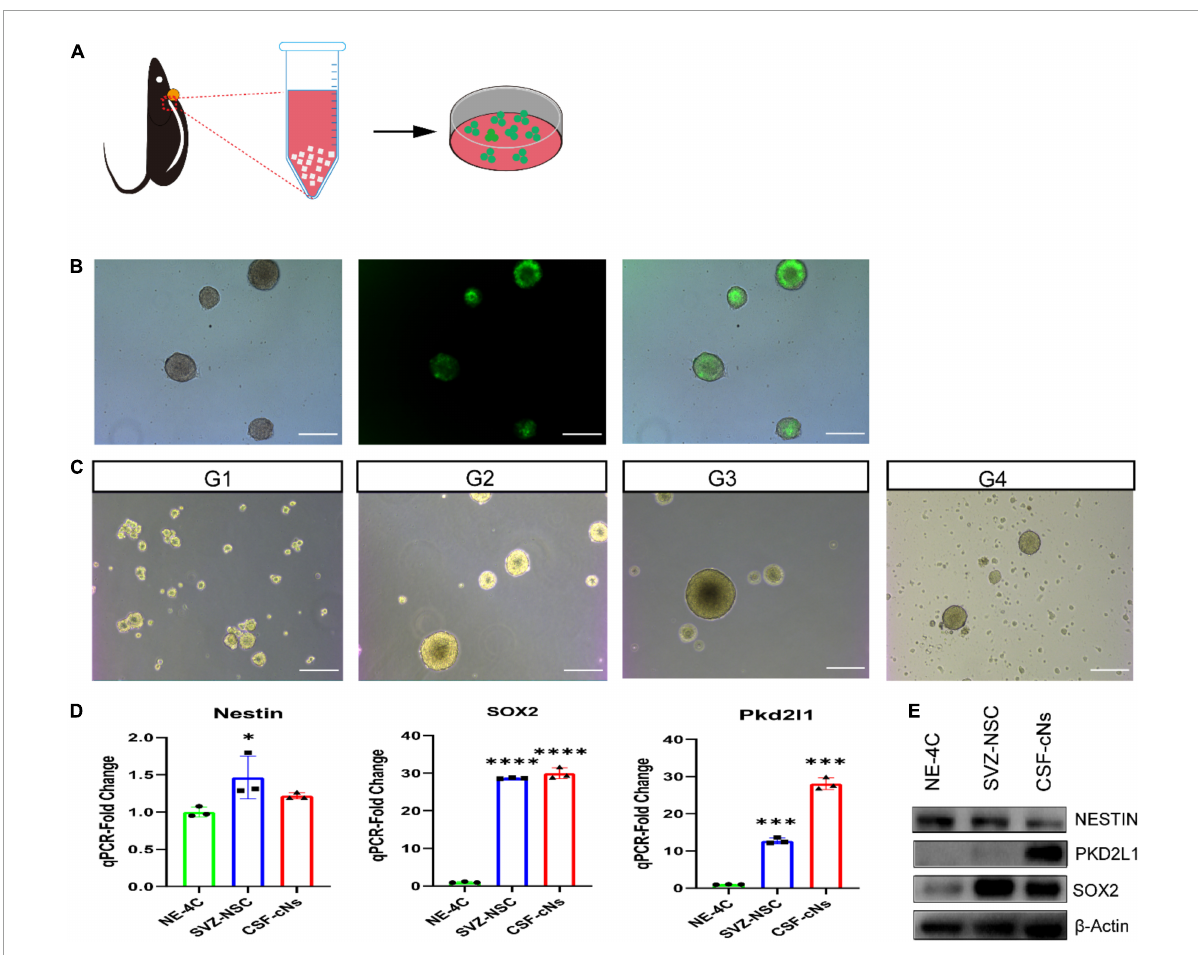
FIGURE2 Cerebrospinal fluid-contacting neurons (CSF-cNs) formed neurospheres and expressed neural stem cell markers. (A) Illustration of CSF-cNs isolation and screening with the addition of lentiviral particles. (B) Target CSF-cNs displayed green fluorescent. (C) CSF-cNs were able to form neurospheres and passage at least four generations. (D,E) qRT-PCR and western blot demonstrated that CSF-cNs have the similar stem cell genes expression compared to NE-4C, SVZ-NSCs, but these cells strongly expressed PKD2L1. ∗ p < 0.05, ∗∗∗ p < 0.001, ∗∗∗∗ p < 0.0001. Scale bar represents 100 µ m in panels (B–C)